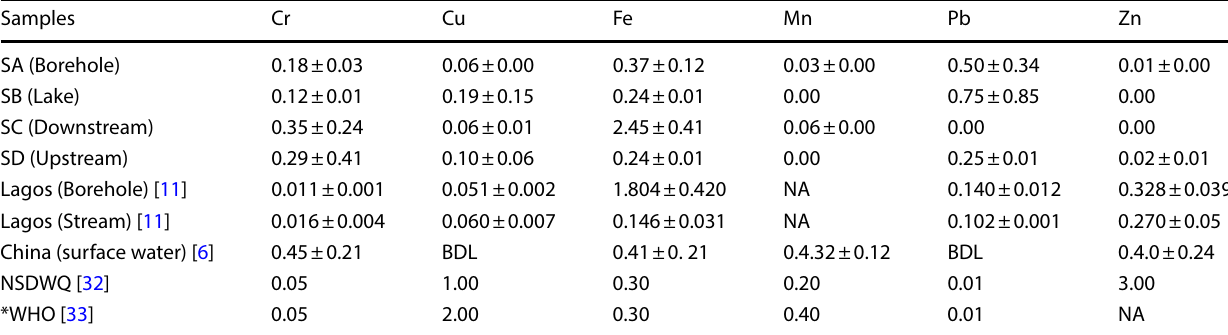
Table 5 Mean concentrations (mg/L) and standard deviations of PTE in studied water samples with some water quality guidelines